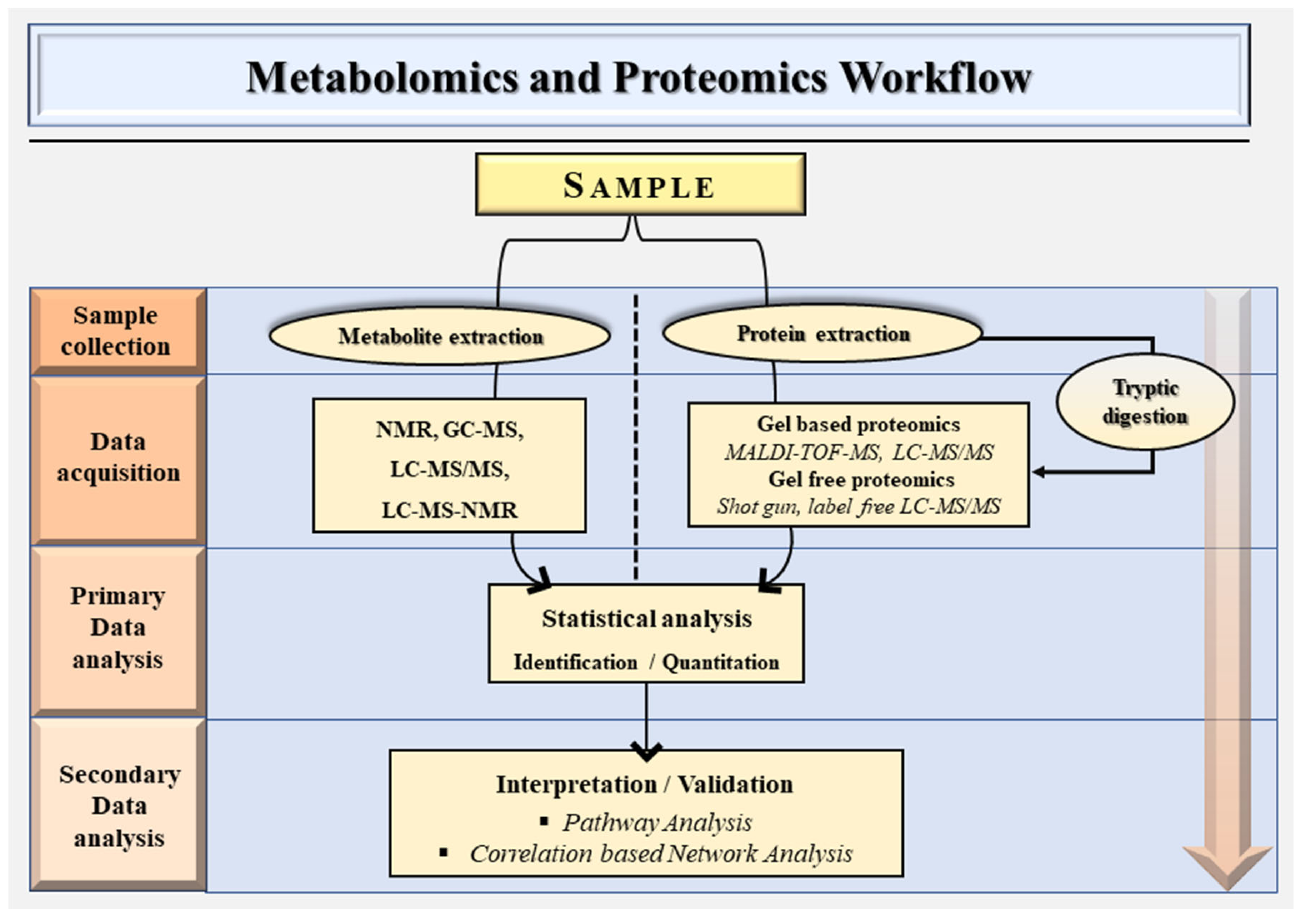
Figure 1. A general schematic overview of the metabolomics and proteomics workflow.